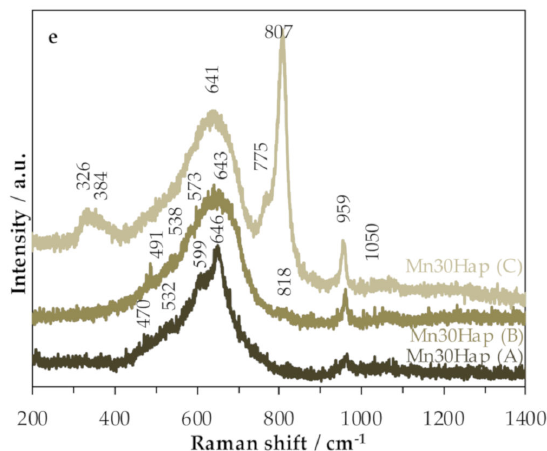
Figure 3. Raman spectra of ( a ) Hap and Mn2.5Hap; ( b ) Mn5Hap; ( c ) Mn10Hap; ( d ) Mn20Hap and; ( e )